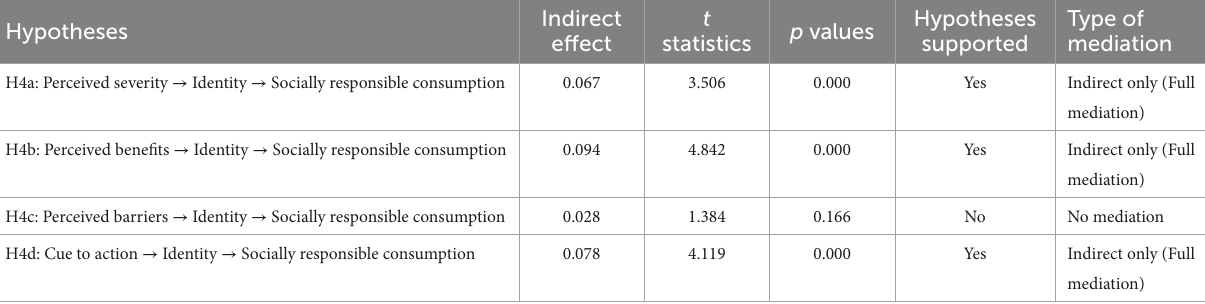
TABLE 8 Mediation analysis